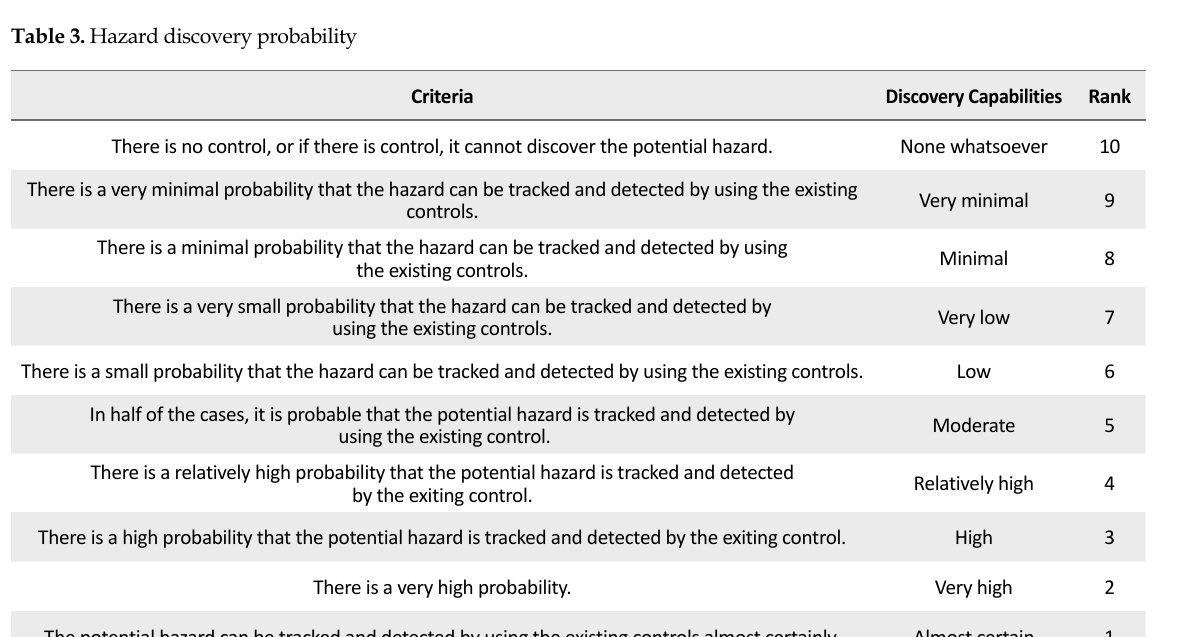
Table 3. Hazard discovery probability